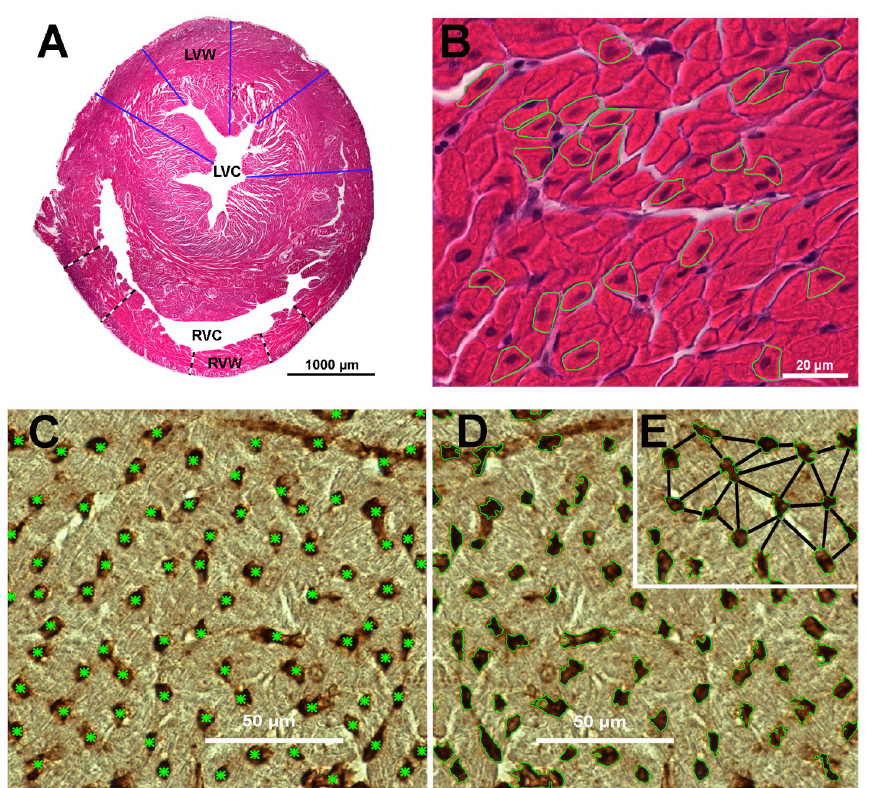
Fig 2. Transverse section of heart ventricular walls of a 63-day-old Lohmann Dual chicken. (A) ventricular wall thicknesses (black-white lines are of the right ventricular wall; blue lines are of the left ventricular wall; (LVC) left ventricular cavity; (LVW) left ventricular wall; (RVC) right ventricular cavity and (RVW) right ventricular wall), (B) representative cardiomyocytes outlined in green, (C) blood capillaries are each indicated by a green asterisk, (D) the area occupied by capillaries is each outlined in green, (E) intercapillary distances; the capillary distances between the nearest neighboring capillaries. A and B stained with H&E. C, D and E stained with Arachis hypogaea Lectin.